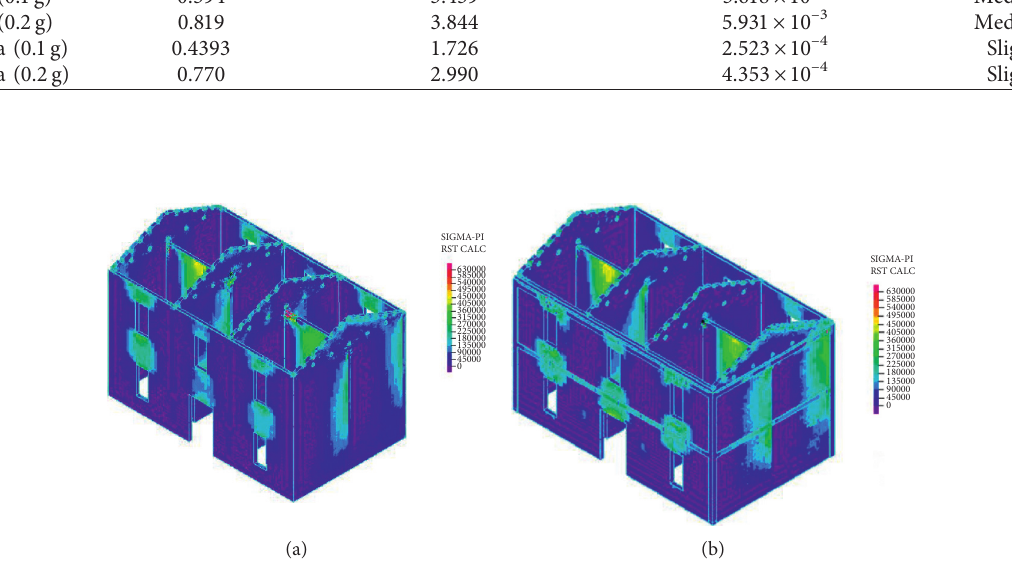
Figure 20: Comparison of main tensile stress of the structure before and after reinforcement. (a) Original structure (before reinforcement). (b) Structure after